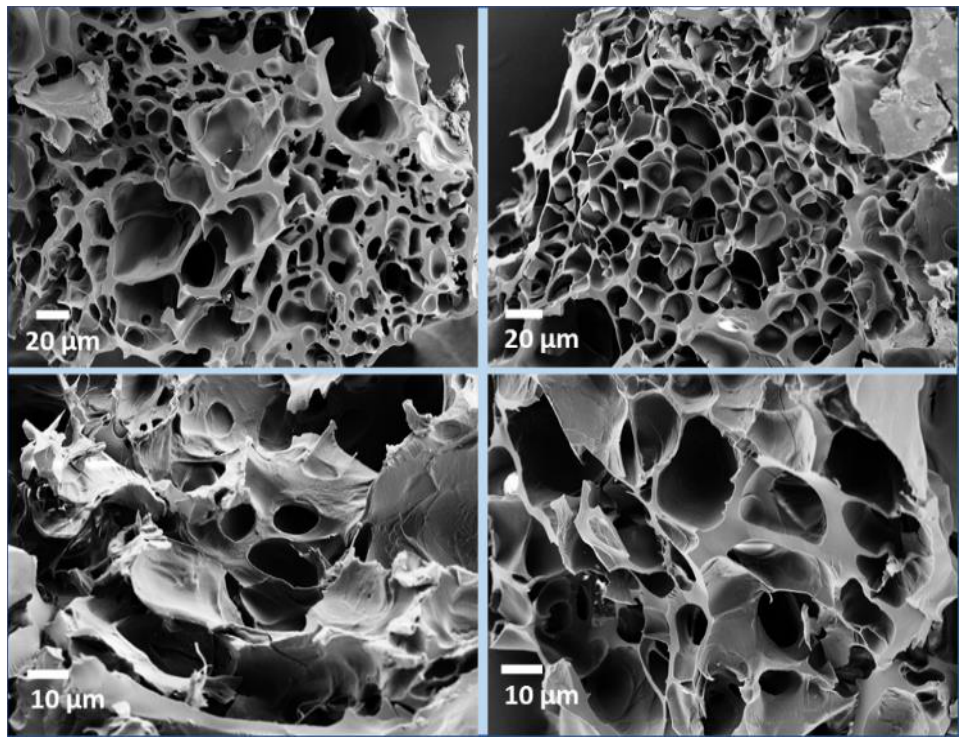
Figure 5. SEM images of freeze dried urazole-potassium hydrogels.